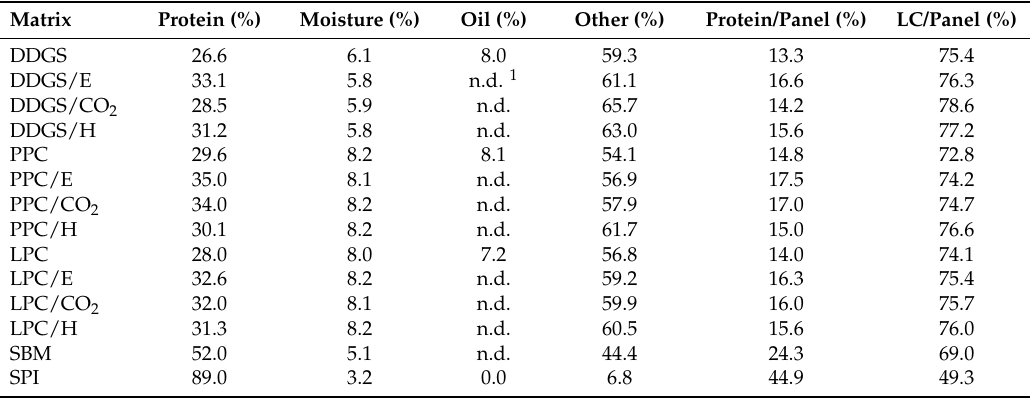
Table 2. Percent ingredients obtained from the chemical analysis of DDGS, press cakes, and soy products and the percent protein and lignocellulosic